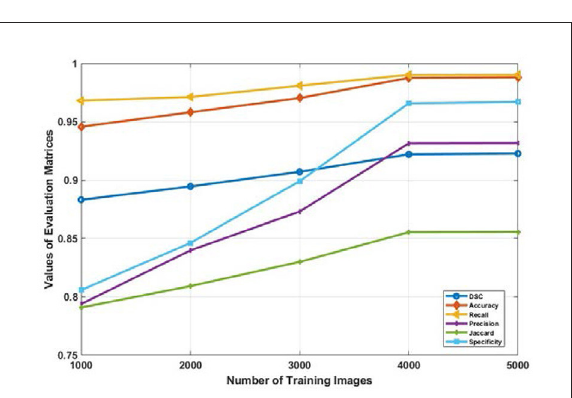
FIGURE8 Average values of evaluation metrics for different data size used for training the Mask R-CNN